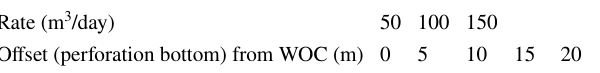
Perforation top was assumed 2 m below GOC for all